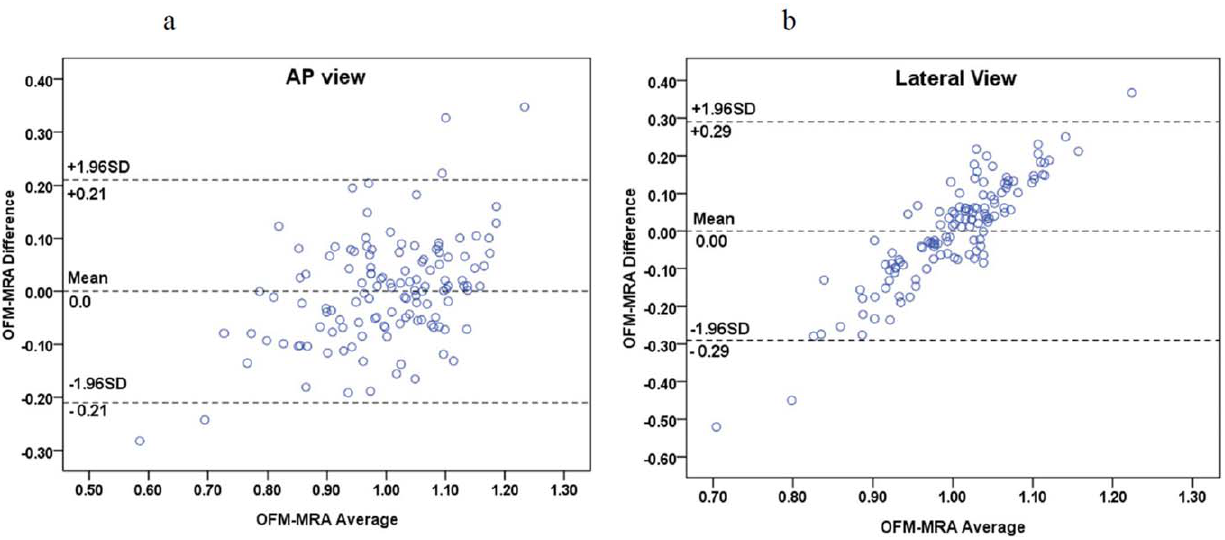
Figure 5. A Bland-Altman plot of the OFM calculations and MRA measurements: (a) AP view; (b) lateral view.